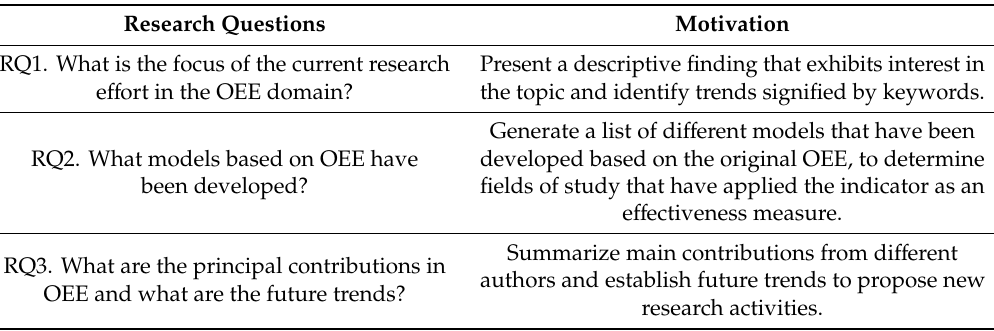
Table 1. Research questions and